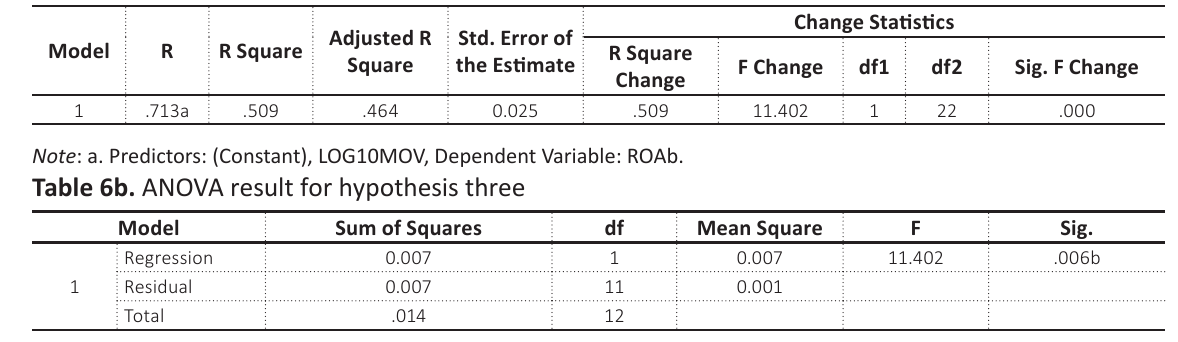
Table 6c. Coefficients result for hypothesis three